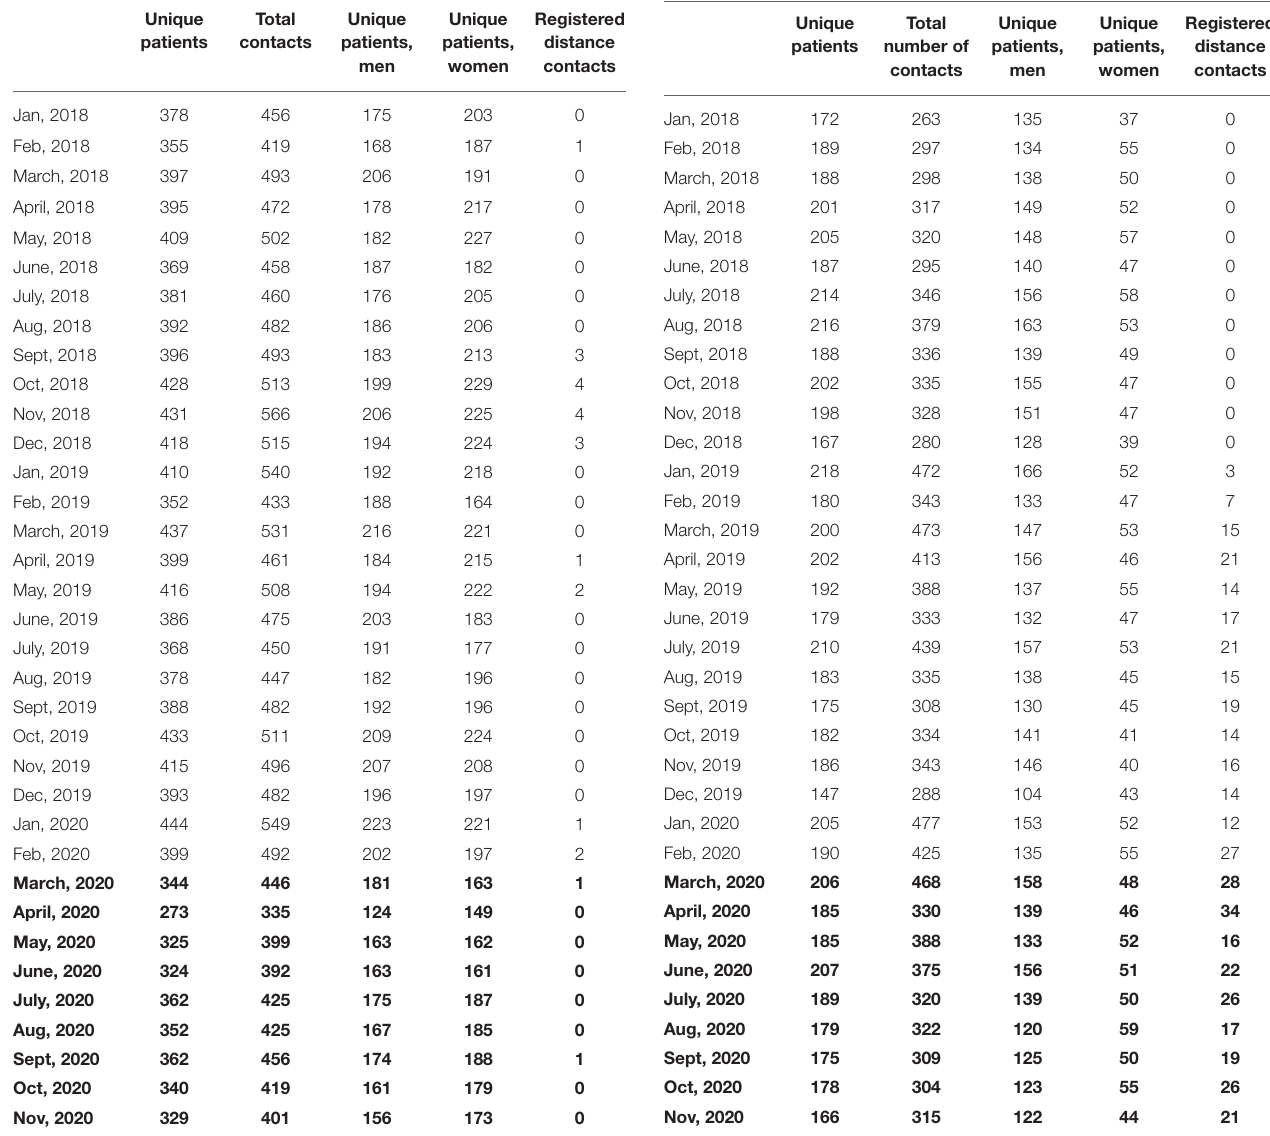
TABLE 2 | Psychiatry emergency contacts in Malmö psychiatric emergency unit,